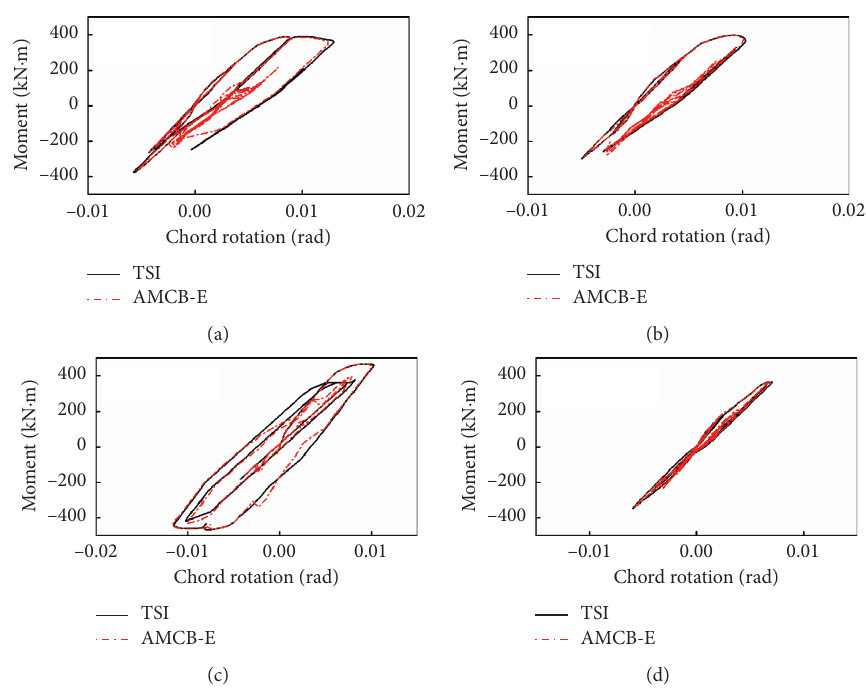
Figure 9: Moment-rotation curves. (a) El Centro. (b) Kobe. (c) Northridge. (d)